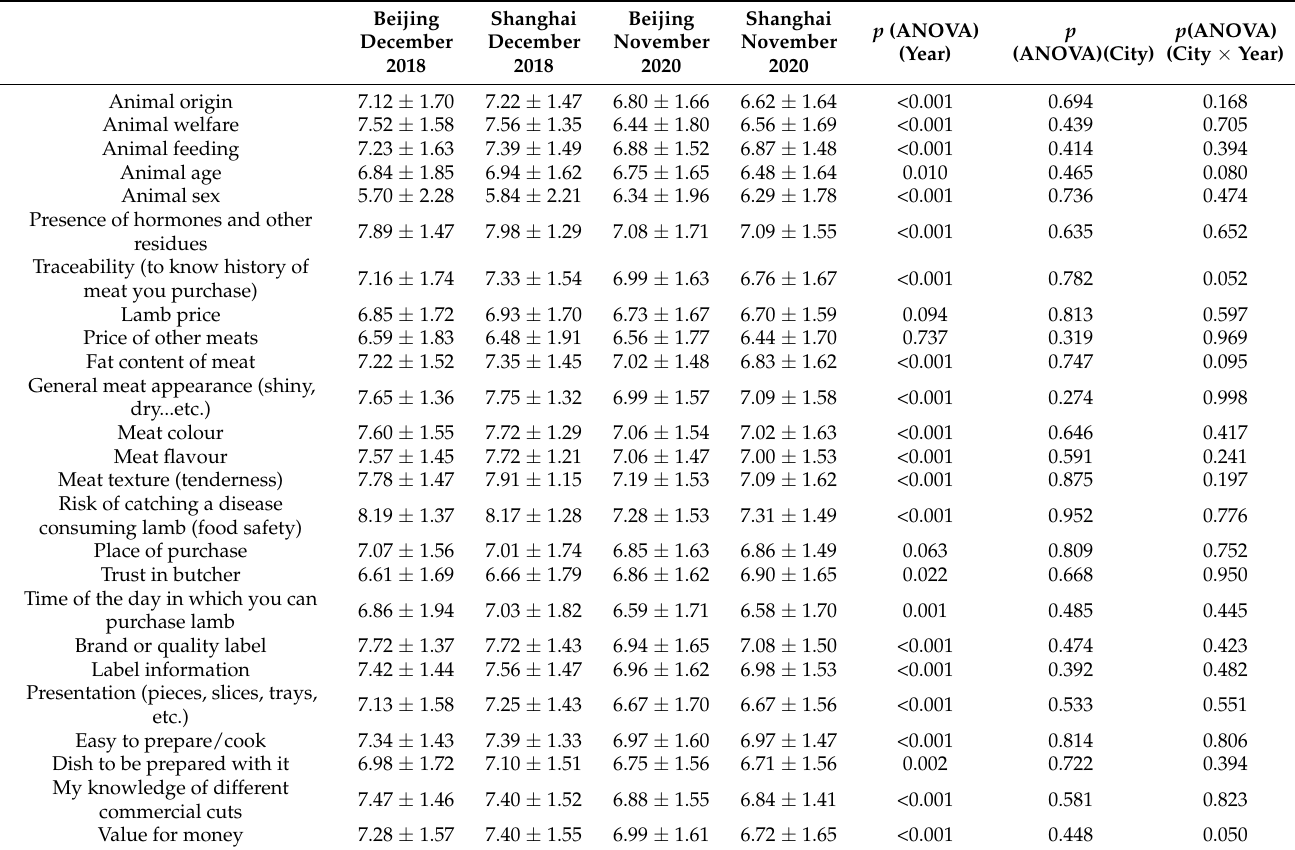
Table 4. The relative importance of lamb attributes at the point of purchase (mean ± SD) (1 = not important, 9 = very important). ( p value determined using a two-way ANOVA with year and city as the main